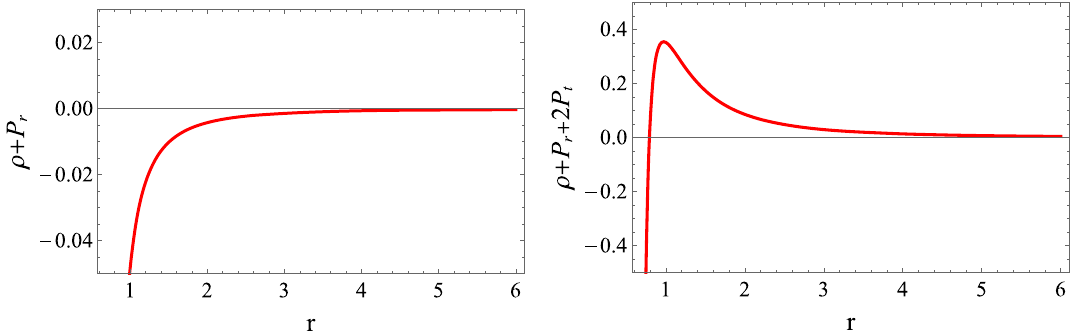
Fig. 6 The behavior of NEC and SEC diagrams have been plotted for the anisotropic wormhole against r . Here also NEC is violated, this implies WEC is also violated. For plotting the constants are α = 0 . 1 and r 0 = 1 along with ω t = − 1 / 3